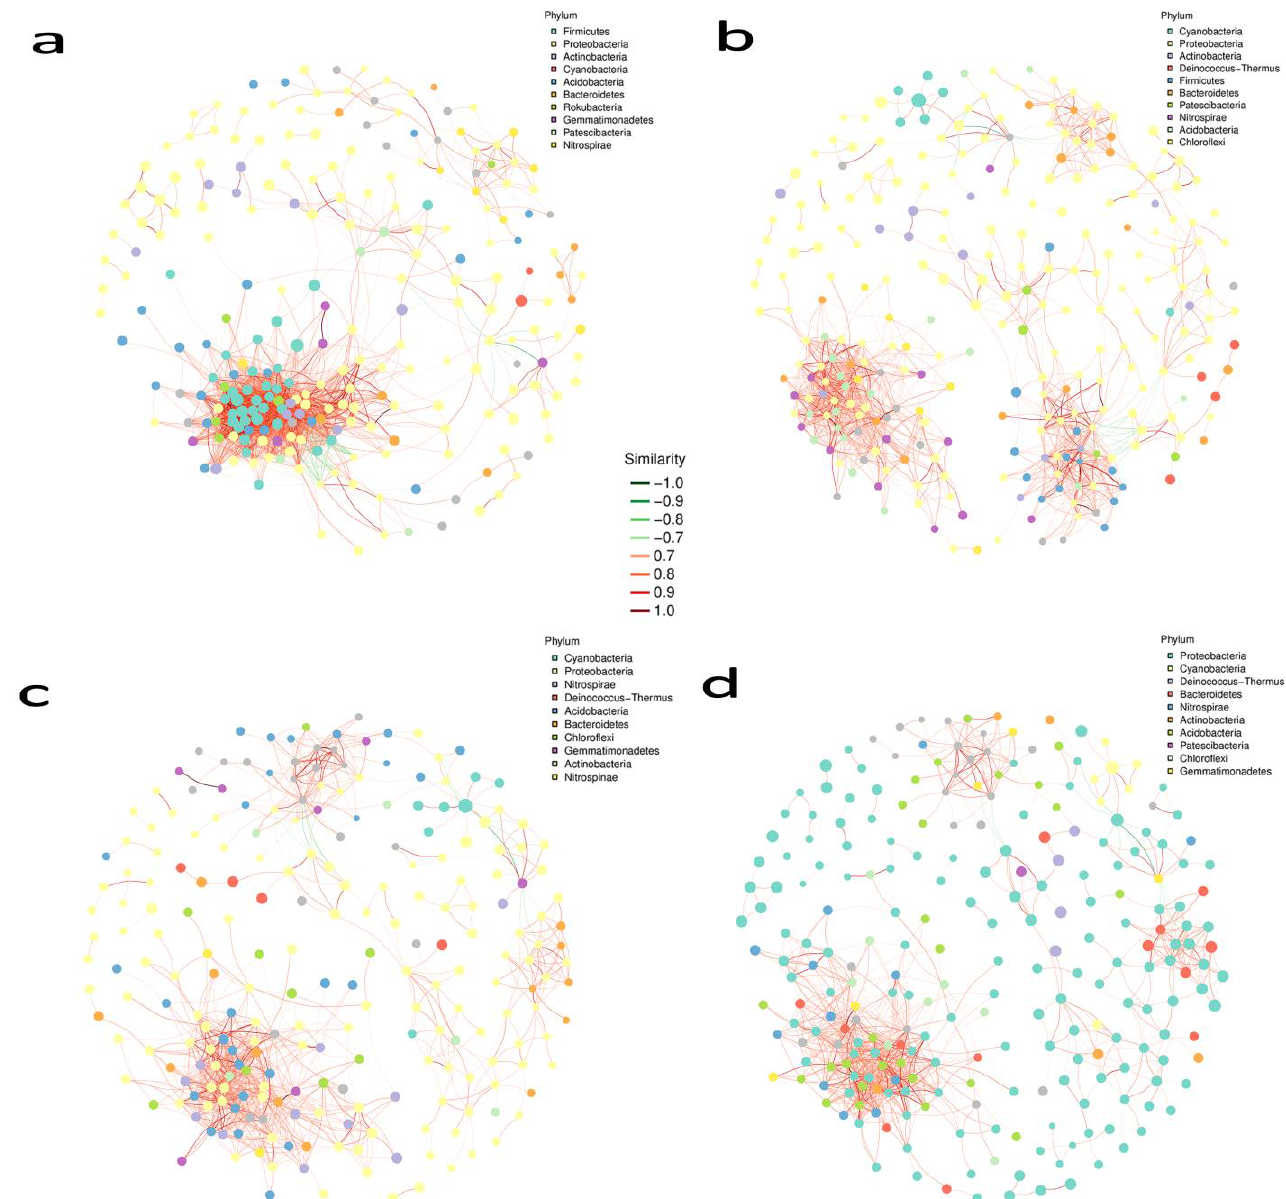
Figure 6. Network analysis of grape rhizosphere and phyllosphere bacterial communities. ASVs with less than 10 total sequences and less than 5 samples were filtered out. Nodes denote different interacting phyla. The top 10 modules (phyla) with the most significant number of interacting nodes are shown with their respective colours. Node size is proportional to the abundance. Edges connect different nodes with red and green lines as positive and negative correlations, respectively. ( a ) Rhizosphere soil, ( b ) white roots, ( c ) leaves, ( d ) berry.